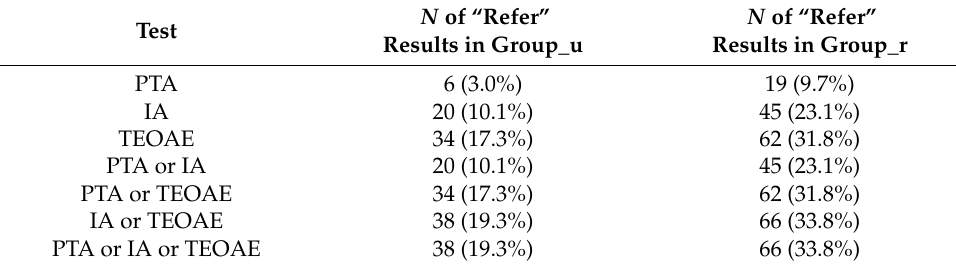
Table 5. Summary of the number and percent of ears with “refer”